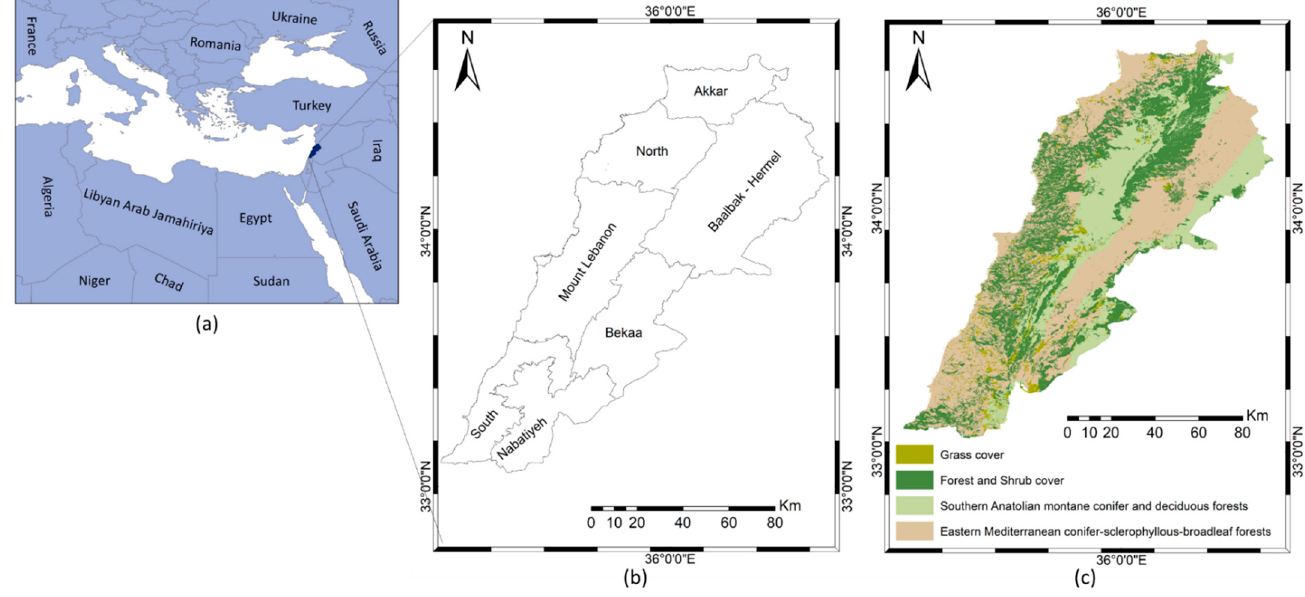
Figure 1. ( a ) Location of Lebanon within the Mediterranean basin; ( b ) administrative units overlayed with ( c ) the forests/shrublands and grasslands (adapted from [48]), and ecoregions (adapted with permission from [47], 2022, World Wildlife